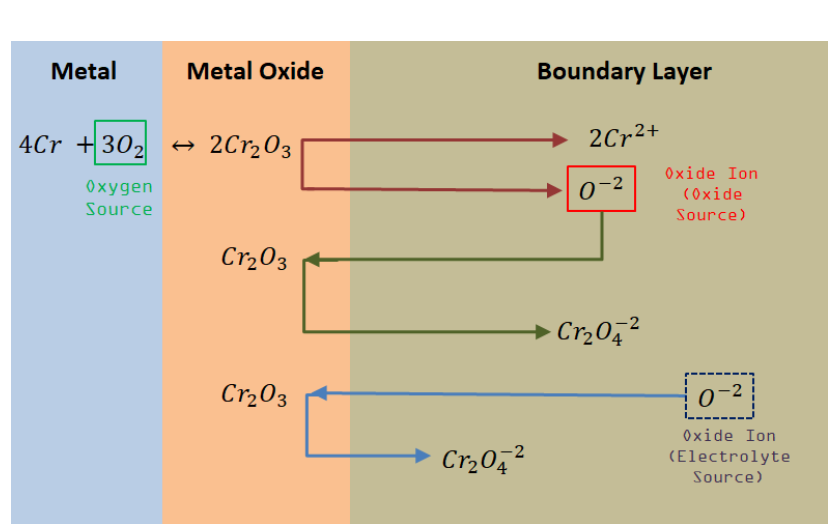
Figure 4. Corrosion mechanisms of Cr in contact with Oxyanionic Salts.